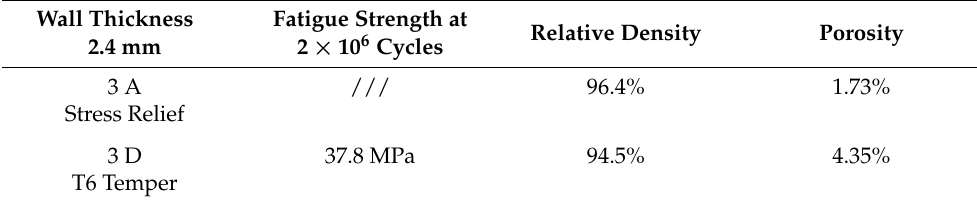
Table 4. Characteristics of the samples with a thickness of 0.6 mm.